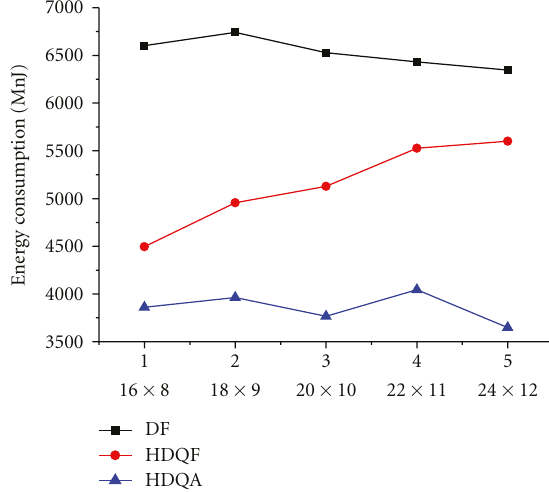
Figure 11: Energy sensitivity of query region